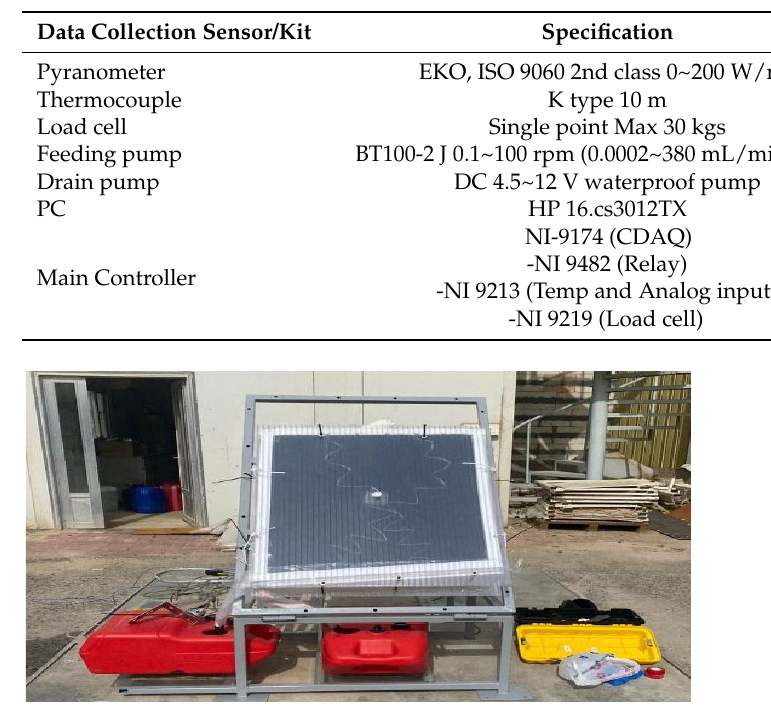
Table 1. Instruments and sensors used in the MSS experimental setup.